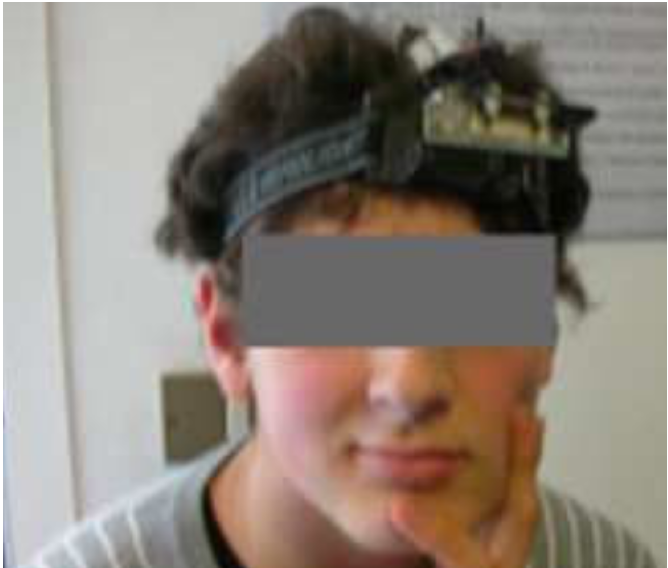
Figure 2. The head band of HATCAM showing a camera and mirrors to detect the eye gaze of the subject ( c (cid:13) 2010 IEEE. Reprinted with permission